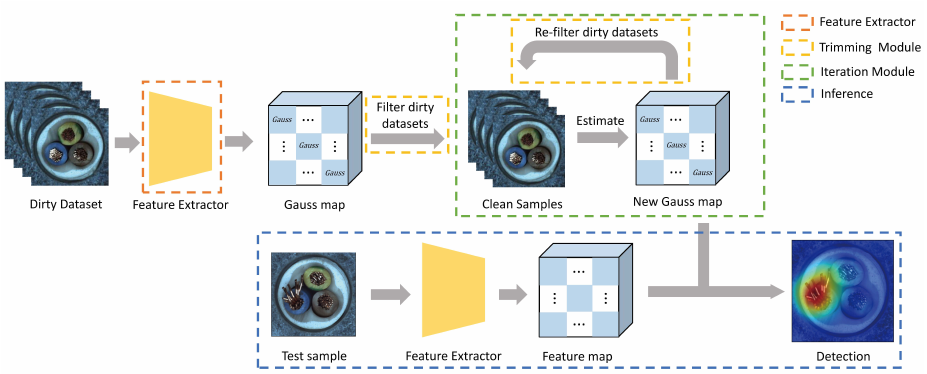
Figure 2. The structure of our proposed method PaIRE.